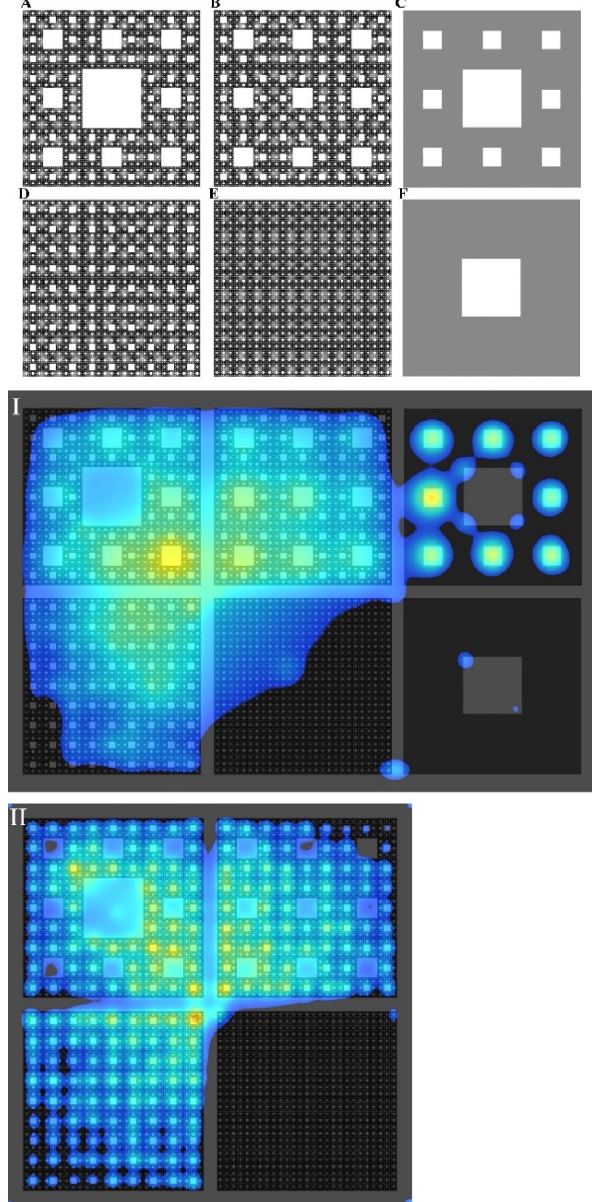
Figure 11. The Sierpinski Carpet geometrical fractal ( A ) missing either large ( B , D , E ) or small scale levels ( C , F ). In figure I , the visual attention heatmap ignores those figures that lack fractal (hierarchical) scaling; whereas figure II shows the same result among only four choices.